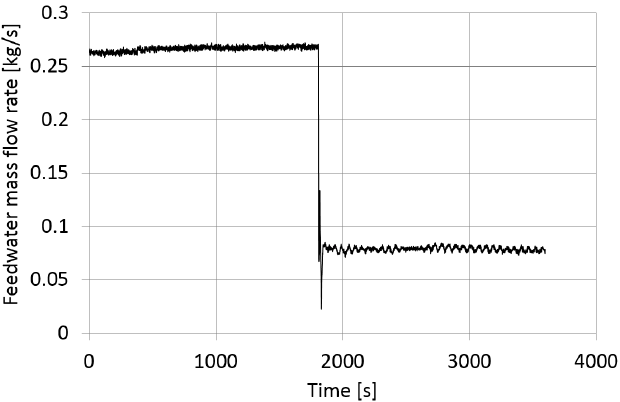
Figure 3. Lead-Bismuth Eutectic (LBE) mass flow rate time trend.